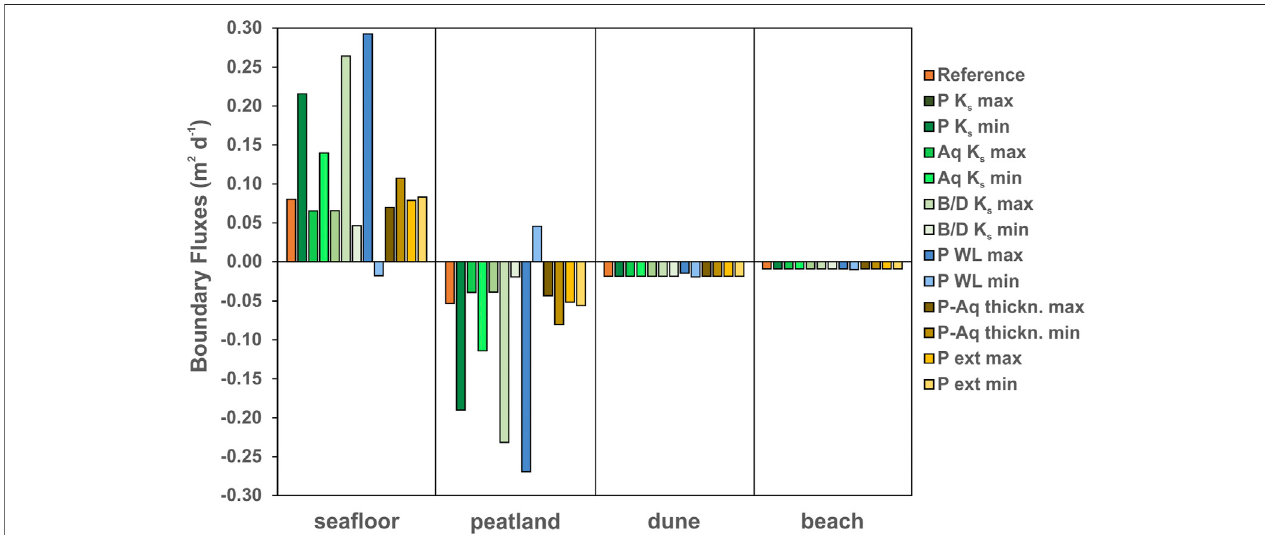
FIGURE 4 | Net boundary fl uxes of the reference scenario (orange) and selected scenarios of soil physical properties (green shades), hydraulic gradients (blue shades), and geological strati fi cations (yellow shades). For location of boundaries, see Figure 2 (sea fl oor a Constant Pressure Head two; peatland a Constant PressureHeadthree;dune a atmospheric;beach a seepageface).Fluxesfromtheleftboundary(ConstantPressureHead1)werenotincludedduetolowvalues(10 – 4 to 10 – 6 m 2 d − 1 ). Notations: P, peat; Aq, aquifer; B/D, beach/dune; WL, water level; ext,